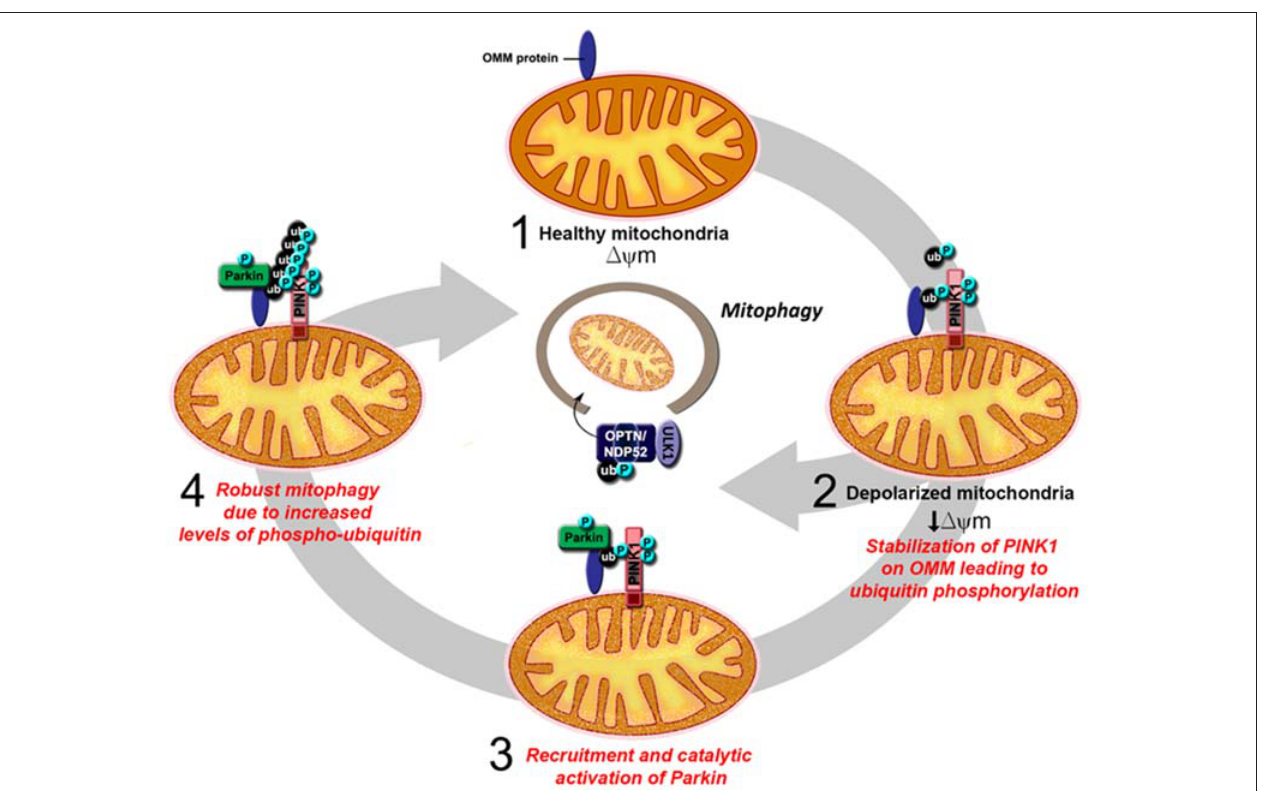
FIGURE 3 | An updated model of PINK1/Parkin-mediated mitophagy. (1) In healthy mitochondria, there is no accumulation of PINK1 on the outer mitochondrial membrane (OMM) as the protein is rapidly imported, processed and degraded. (2) Upon mitochondrial depolarization, full length PINK1 accumulates on the OMM leading to the phosphorylation of ubiquitin on the surface of the mitochondria. This results in the recruitment of the autophagy receptors optineurin (OPTN) and NDP52 and the consequent activation of the mitophagy process, albeit at low level. (3) Parkin is also recruited to the OMM, whose latent activity becomes unmasked due to its interaction with phosphorylated ubiquitin and its phosphorylation by PINK1. (4) Activated Parkin promotes the polyubiqutination of mitochondrial substrates that in turn provides more ubiquitin substrates for PINK1 to phosphorylate. This amplifies the signal for the recruitment of autophagy receptors and results in robust